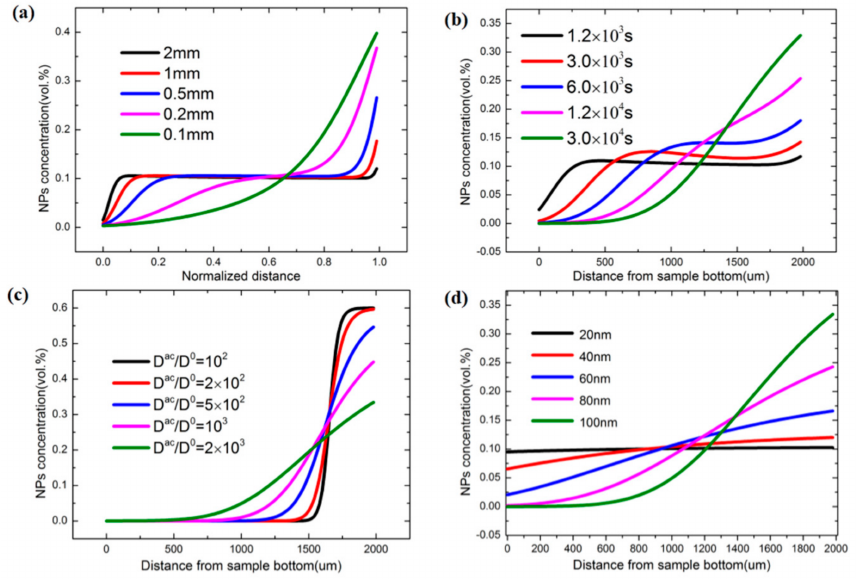
Figure 4. ( a ) Nanoparticle concentration along the normalized distance (e.g., distance from sample bottom divided by sample thickness) for sample thicknesses ranging between 0.1 and 2.0 mm at a sufficiently long processing duration of 1.2 × 10 4 s; ( b ) real-time evolution of the particle concentrations for a 2.0-mm (2000 µ m) thick sample when the diffusion constant is 2000 times larger, and the magnetic particle radius is 100 nm; ( c ) nanoparticle concentration evolution after 1.2 × 10 4 s when particle size is fixed, and the diffusion constant is changed; ( d ) nanoparticle concentration evolution after 1.2 × 10 4 s when the diffusion constant is fixed, and the nanoparticle radius is